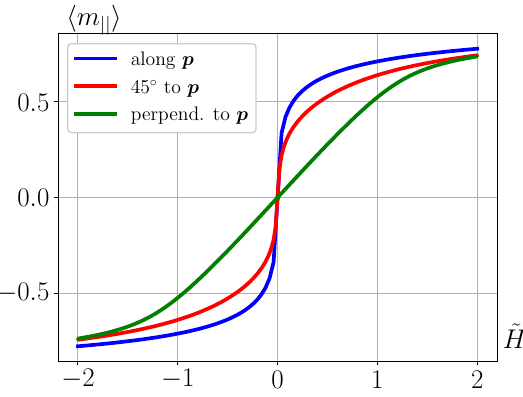
Figure 5. Curves of magnetization along the external magnetic field.